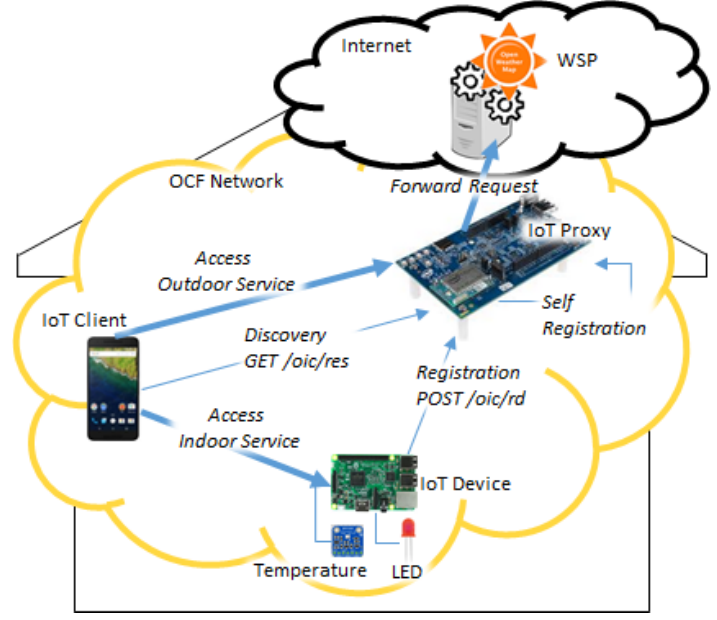
Figure 10. Experimental environment.